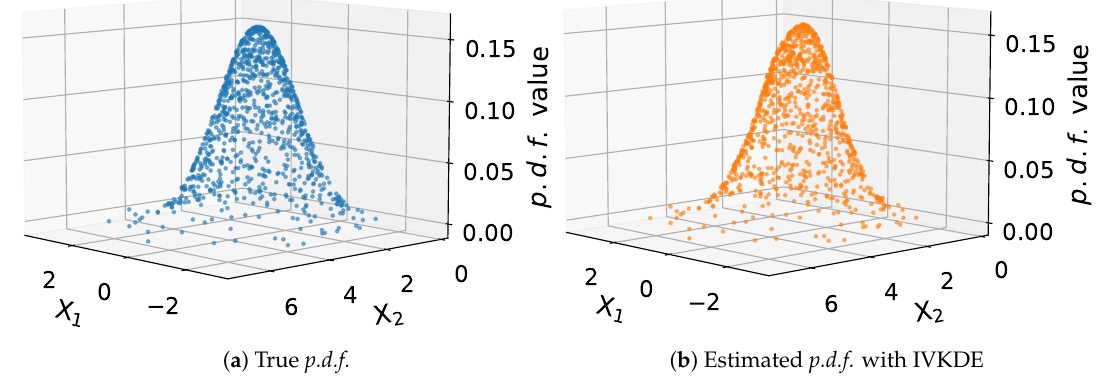
Figure 4. Estimation capability of IVKDE on two-dimensional normal distribution.